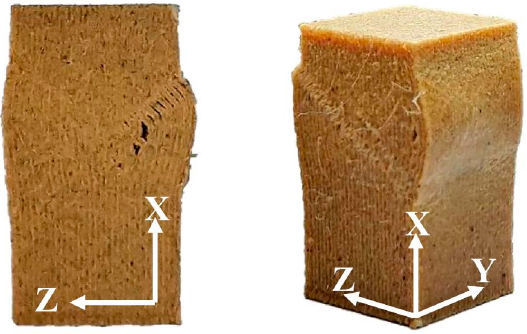
Figure 10. Compressive failure appearances of the FDM-printed WPC part.